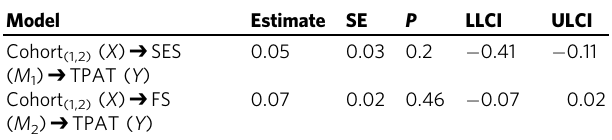
Table 4 Indirect effects of SES and